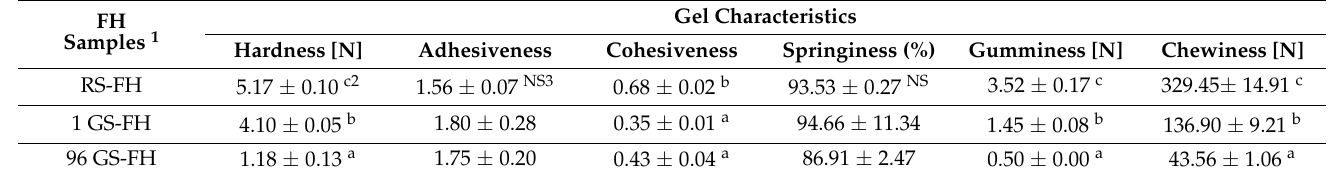
Table 1. Textural properties of filled hydrogel (RS-FH, 1 GS-FH, and 96 GS-FH). FH Samples